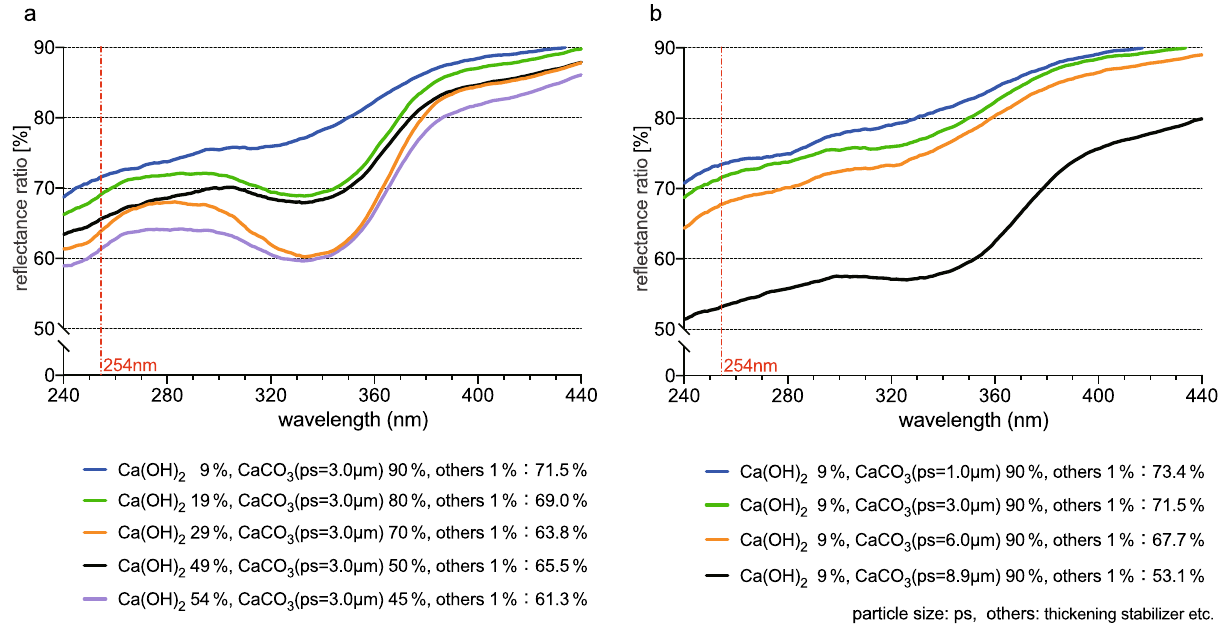
Figure 3. Reflectance ratios of UV lights by ( a ) changing amounts and ( b ) particle diameters of CaCO 3 .